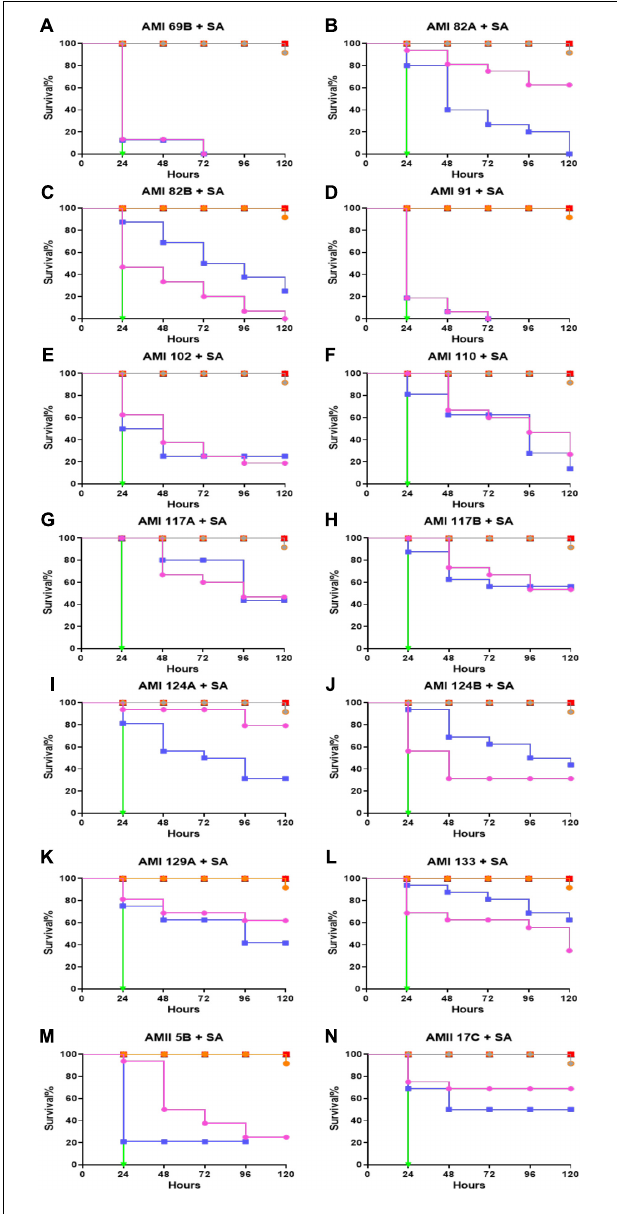
FIGURE 4 | Whole larvae survival assay for protection assessment of the investigational compounds. Plotted here (A–N) are the survival profiles of selected compounds. Legend represents: No treatment; PBS only; DMSO